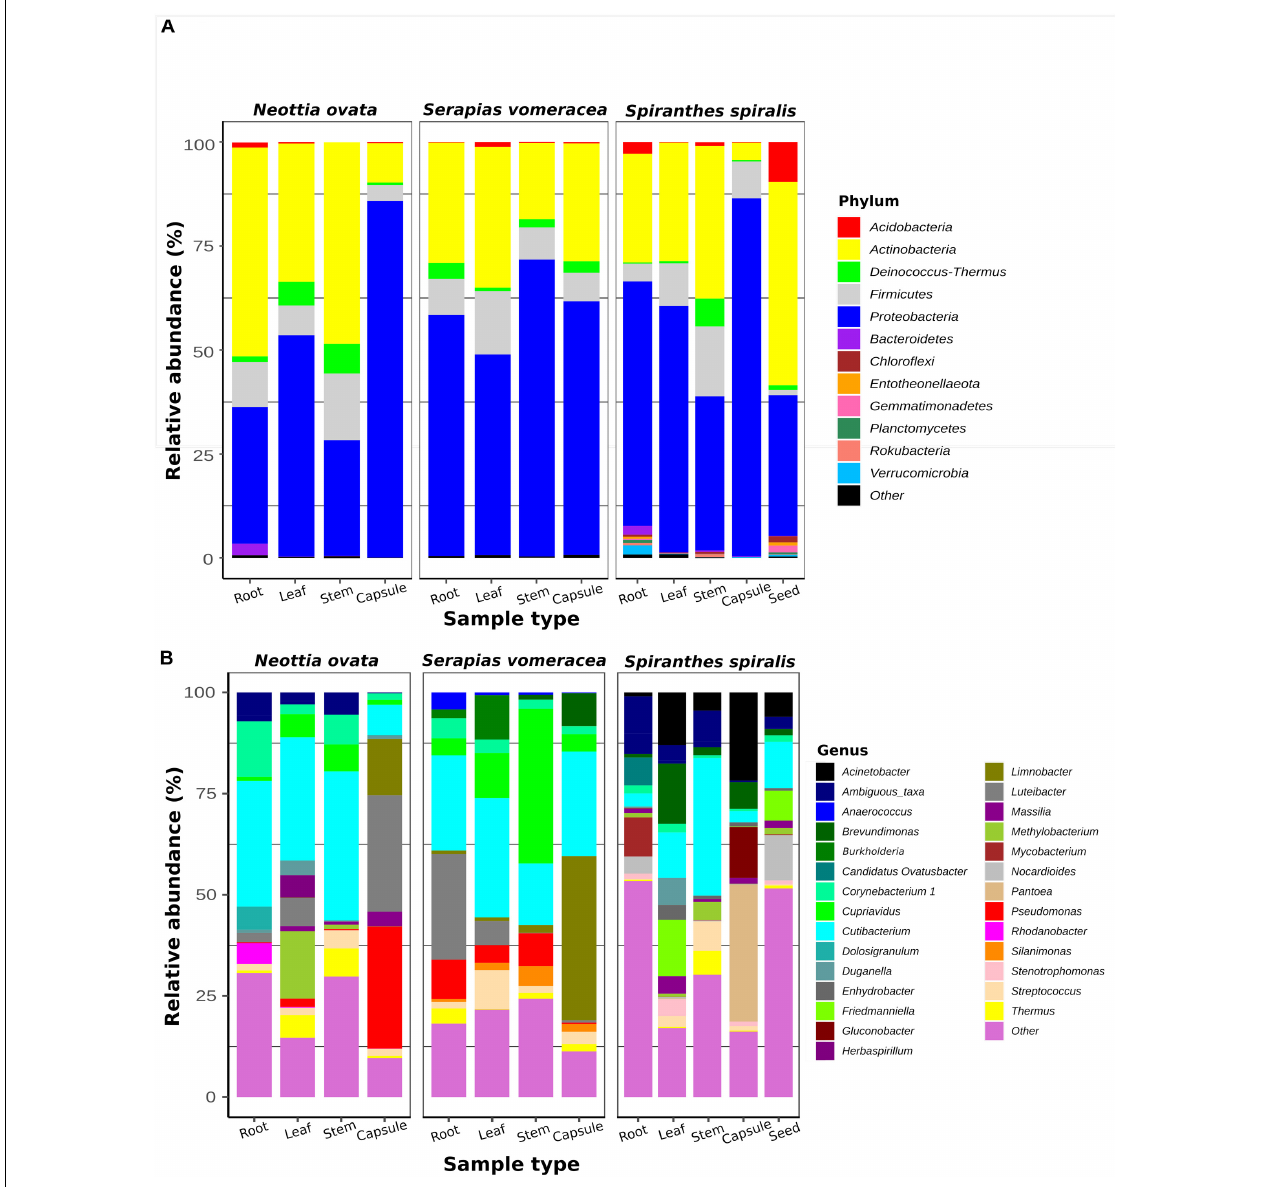
FIGURE 2 | Bacterial taxa distribution in the orchid microbiota. Relative abundance of panel (A) predominant bacterial phyla ( > 1%) and (B) predominant genera ( > 0.5%), as obtained by 16S rRNA gene metabarcoding of orchid plants ( n =